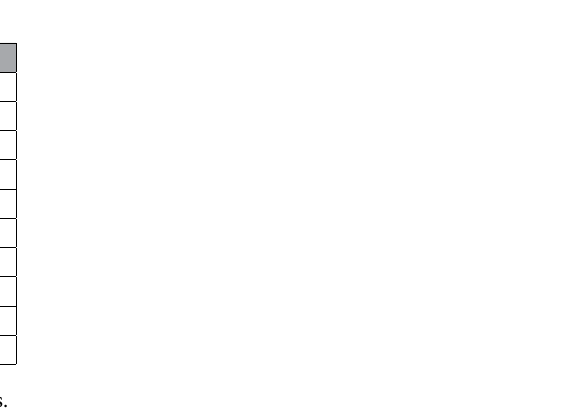
Table 2. Control forces needed on